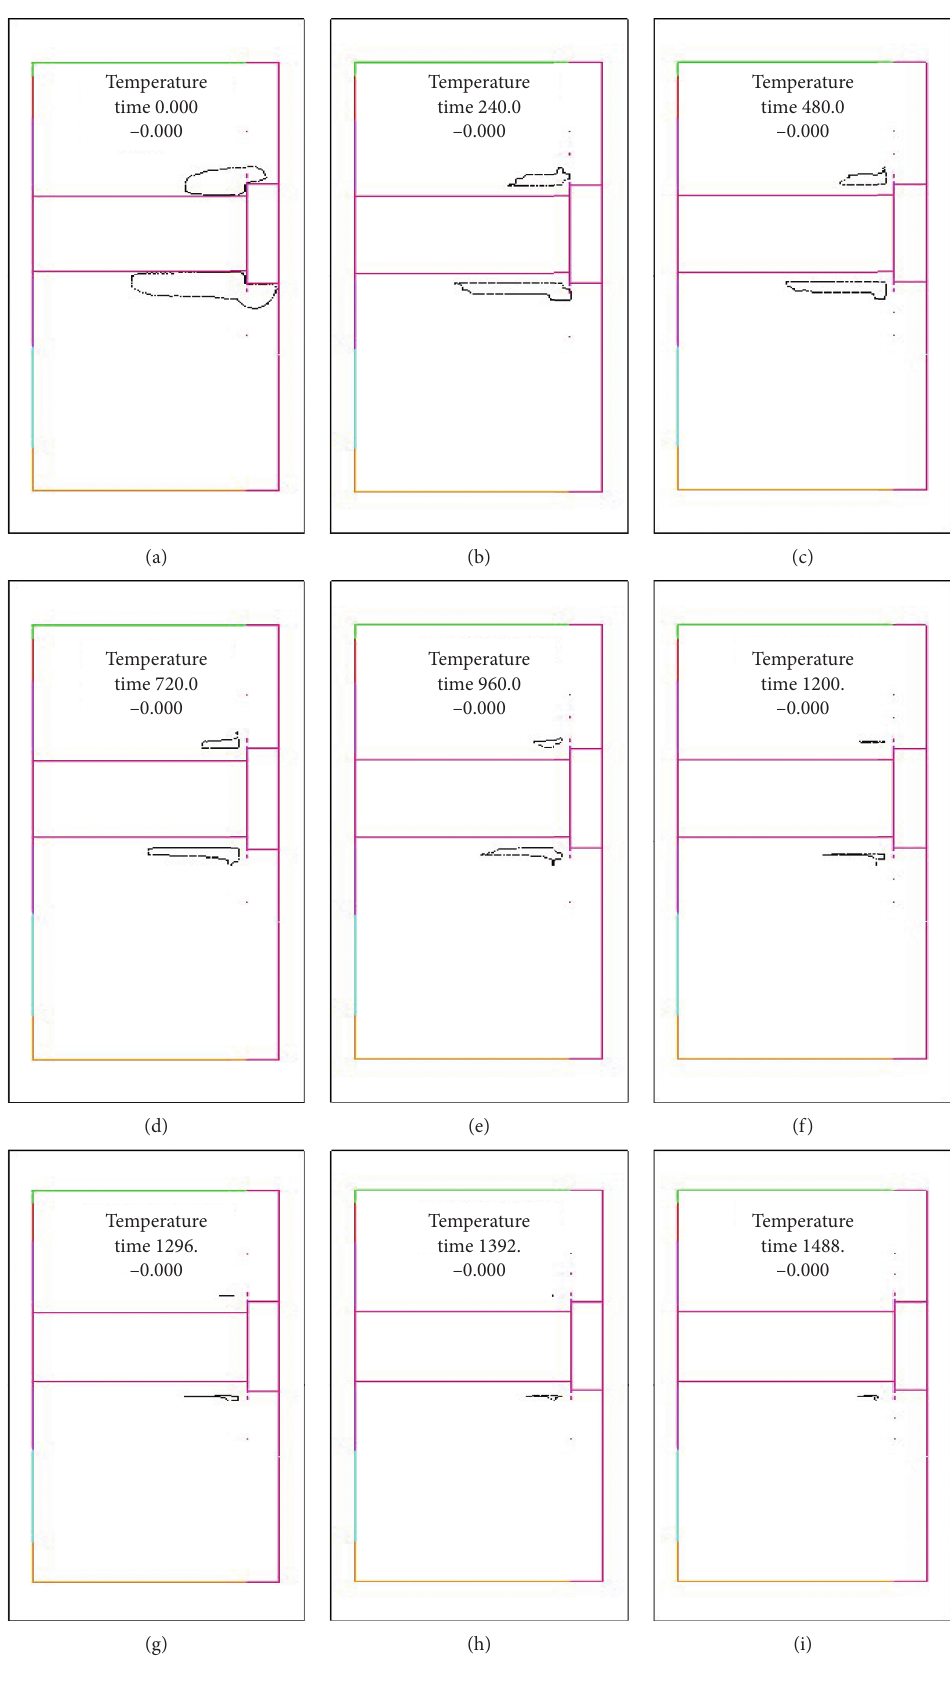
Figure 6: 0 ° isotherm plots at section of Y � 0 with different natural thawing times of (a) 0 days, (b) 10 days, (c) 20 days, (d) 30 days, (e) 40 days, (f) 50 days, (g) 54 days, (h) 58 days, and (i) 62